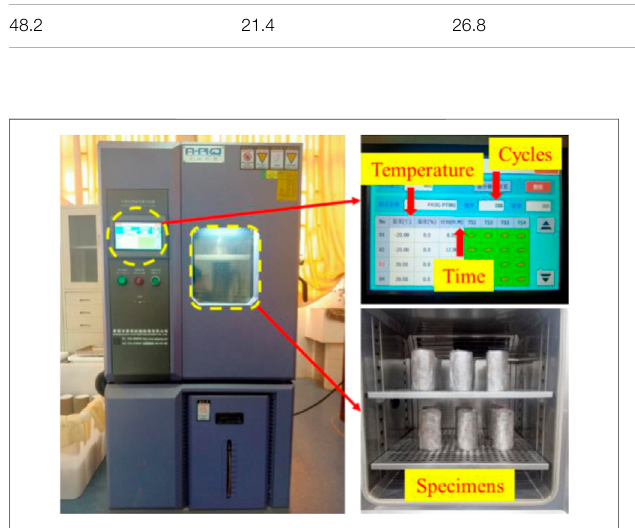
FIGURE 1 | Processing of specimens subjected to FT cycles.